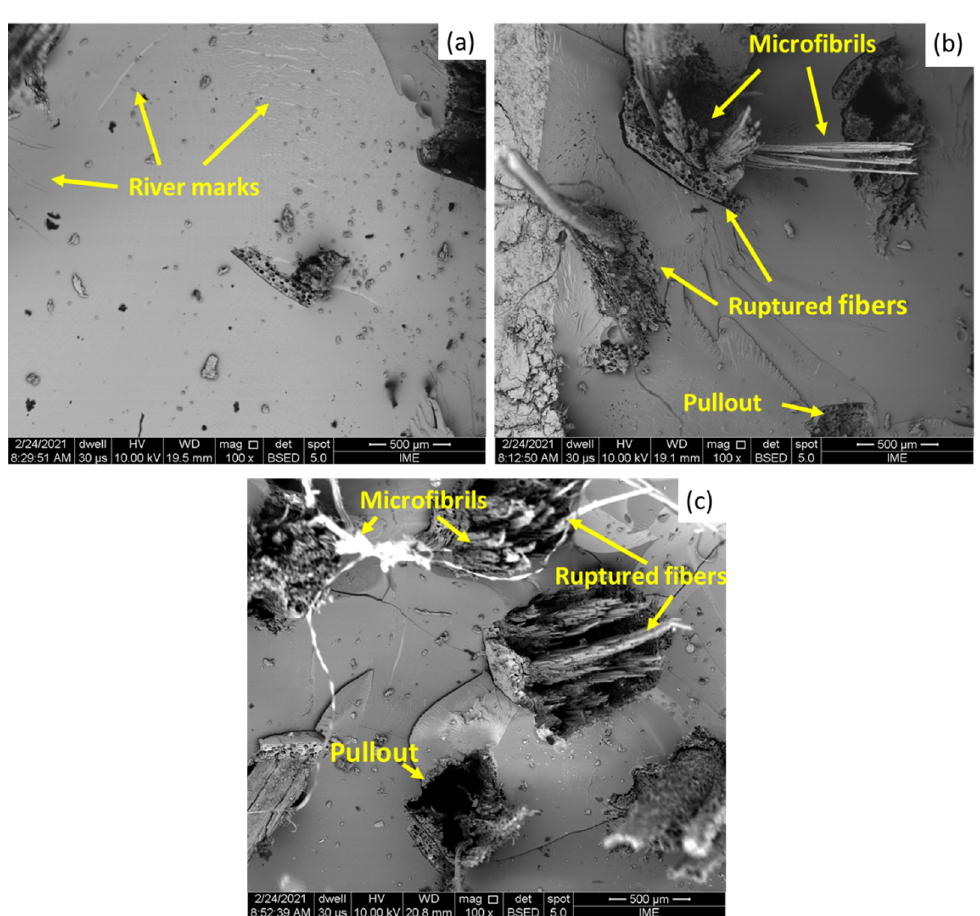
Figure 5. SEM images of the fractured surfaces of the epoxy composites with different volume fractions of guaruman fiber: ( a ) 10, ( b ) 20, and ( c ) 30 vol%.